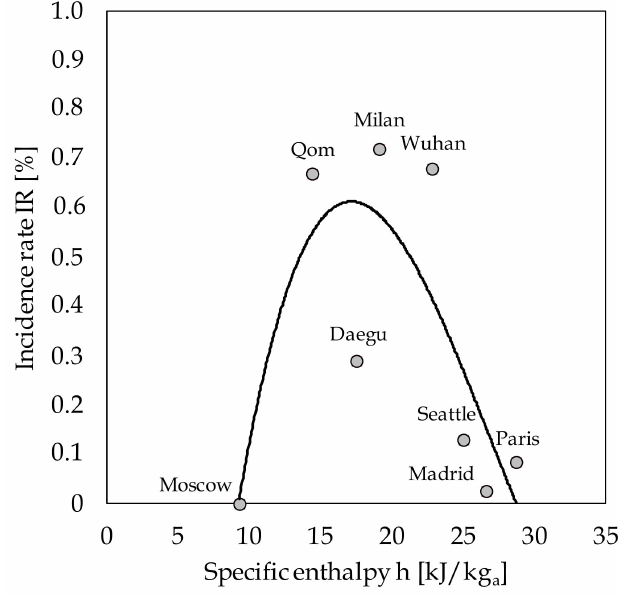
Figure 2. Interpolation curve incidence rate (IR) vs. specific enthalpy (h) for the seven considered cities, with the addition of Moscow (data extracted from the study by Sajadi et al.